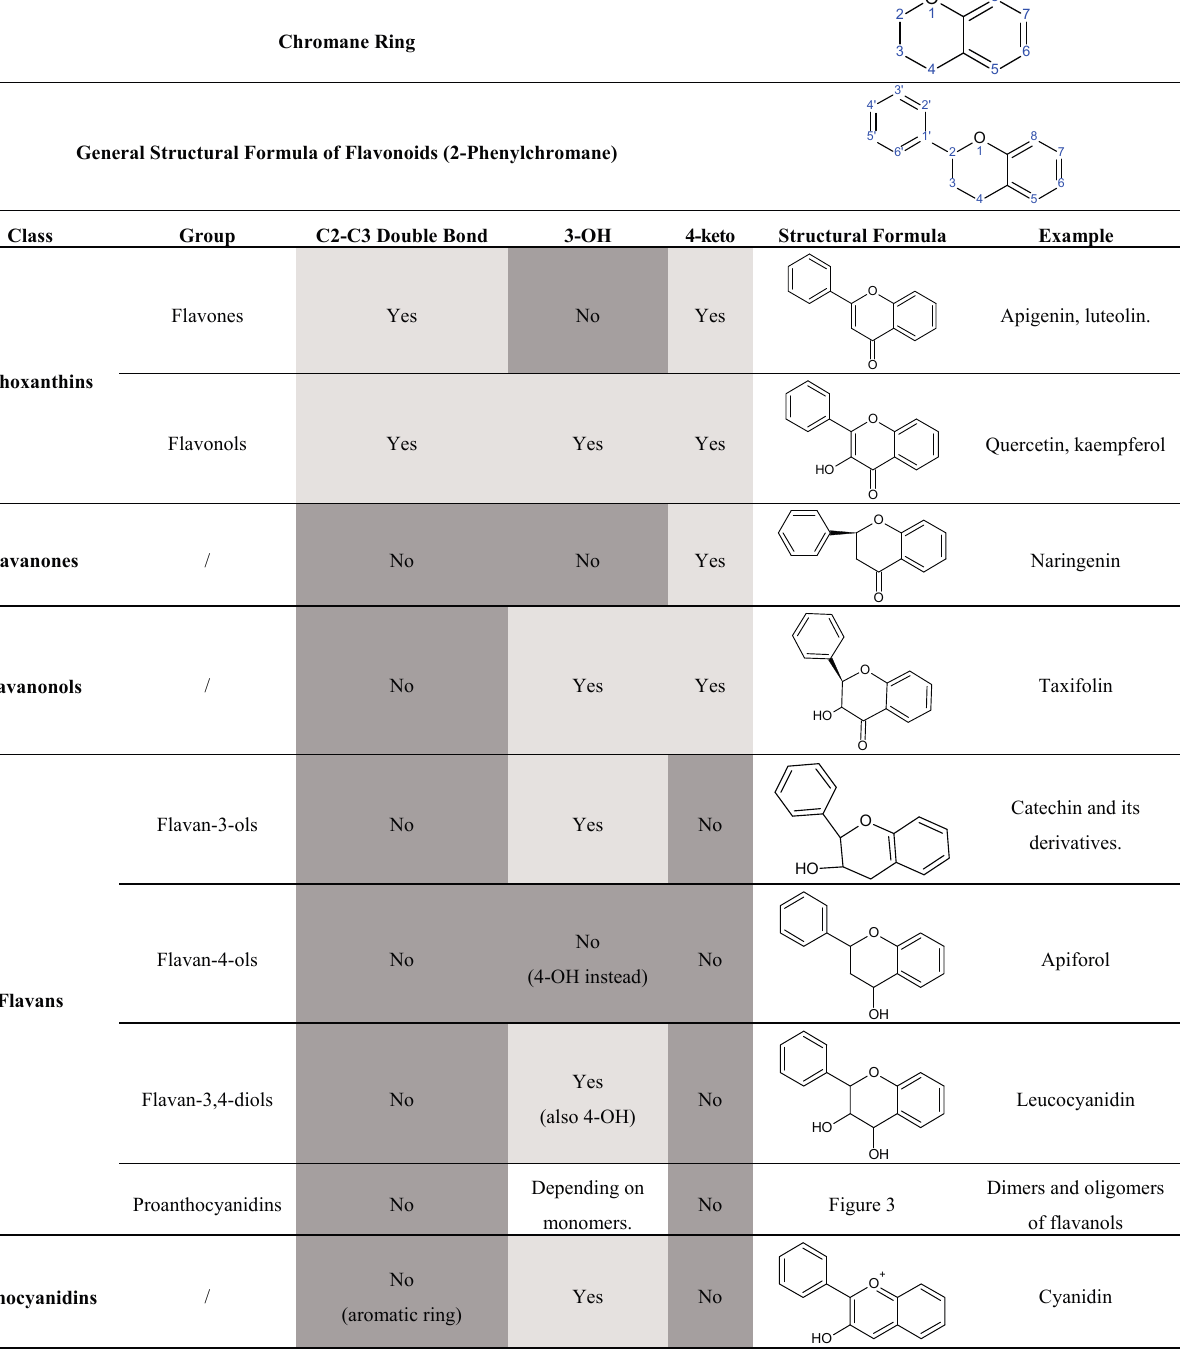
Table 1. Classification and structural formulae of flavonoids.